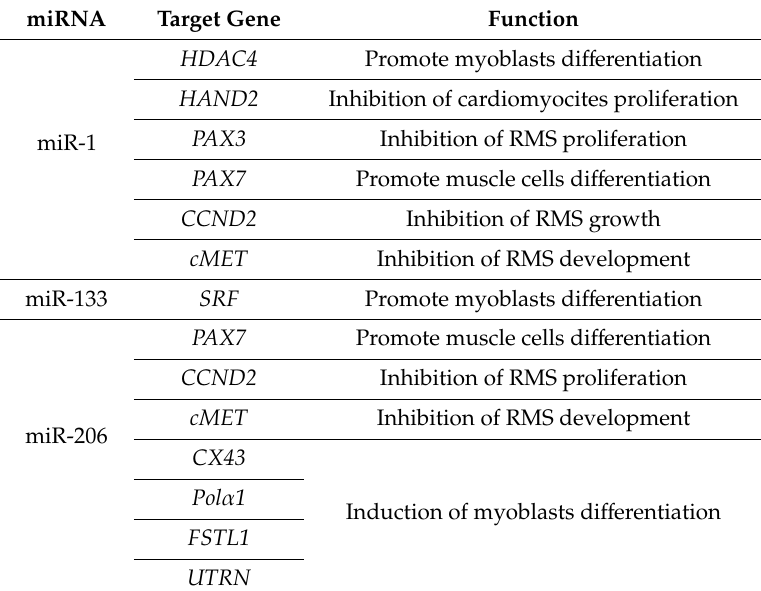
Table 2. Myo-miRNAs in muscle